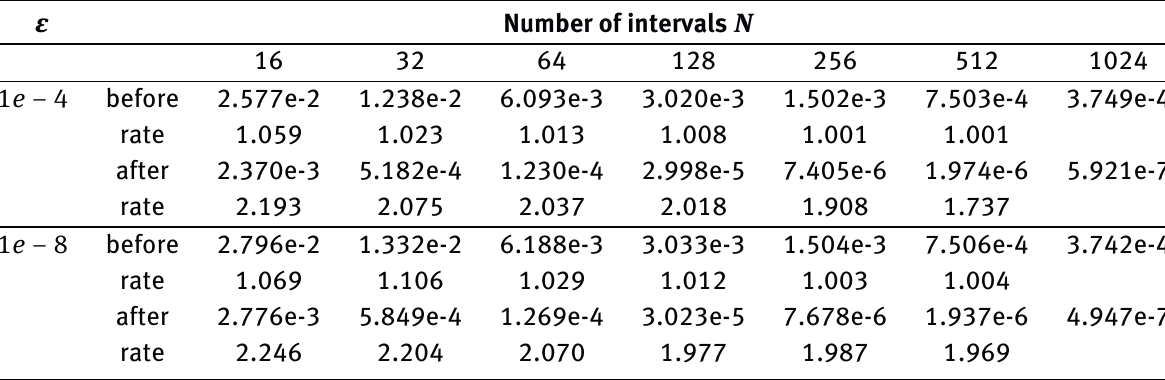
Table 1: E N ε , u and the corresponding r N ε , u for Example 6.1 on the adaptive grid. ε